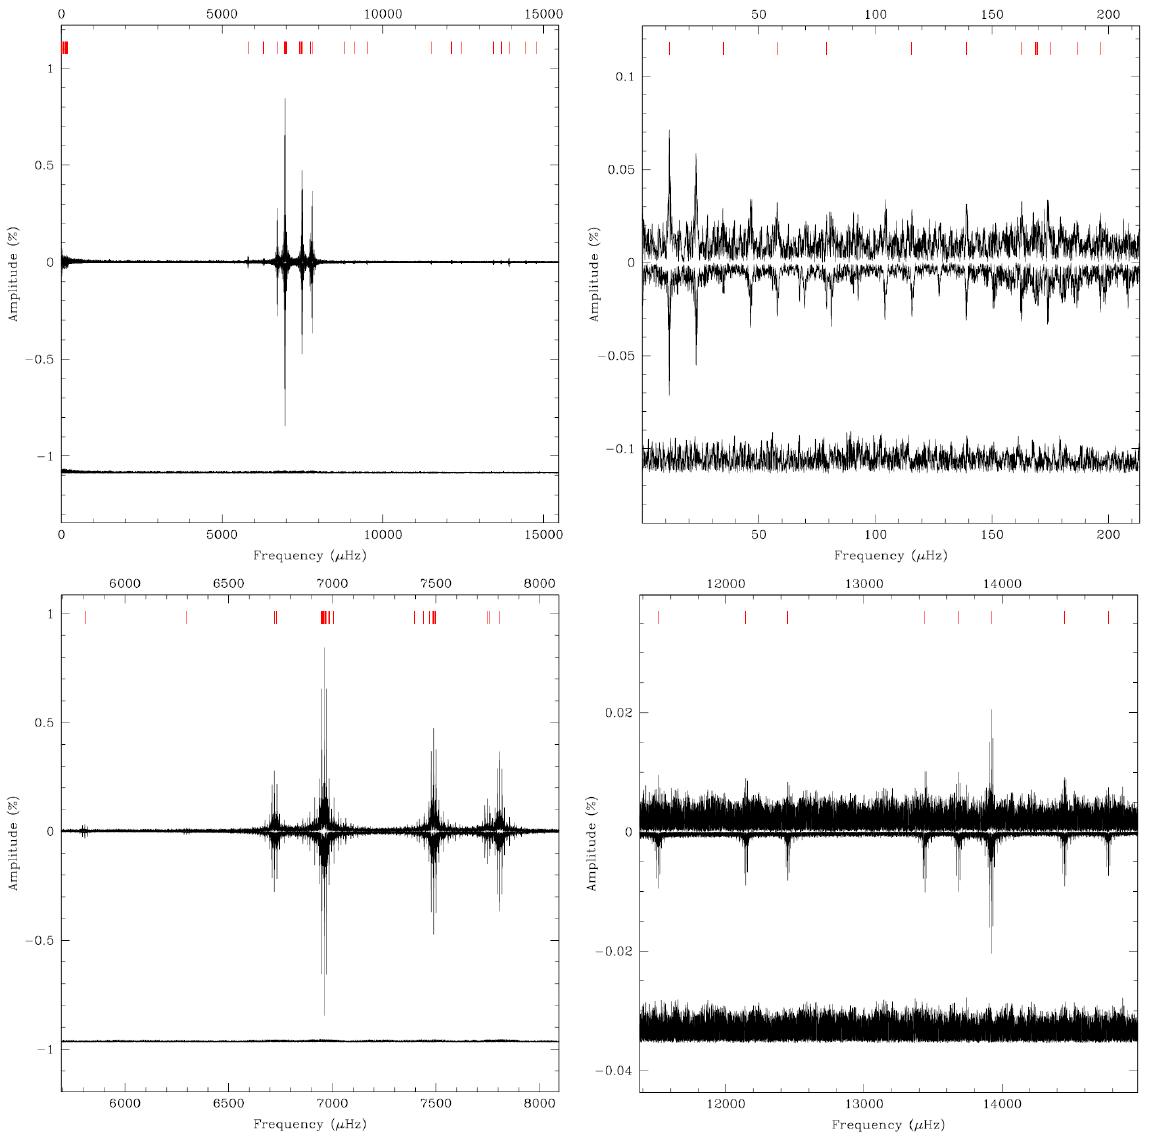
Figure 3. Fourier Transforms (FT) of the entire data set in the 0–15 mHz frequency range ( top left panel ), in the 0–210 mHz ( top right ), in the 5700–8000 mHz ( bottom left ) and in the 11700–14500 mHz frequency range ( bottom right ). In all panels the up FT is the observed full spectrum, while the reverse FT is the model spectrum reconstructed on the basis of the pulsations extracted from the light curve. The curve shifted downward is the point-by-point difference between the actual FT and the model